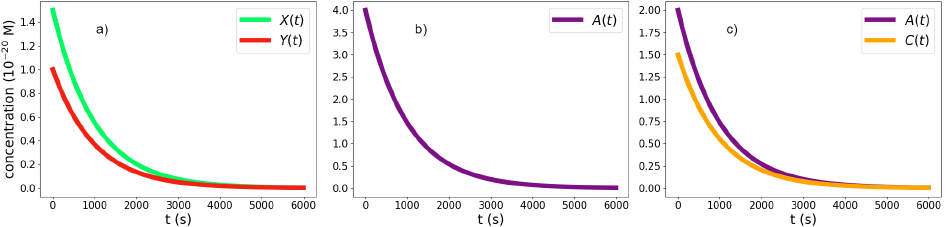
Figure 1. Time dependence of ( a ) X ( t ) and Y ( t ) for RM1 (left) calculated assuming the [ A ] (cid:29) [ Z ] case, ( b ) A ( t ) for the one-currency mechanism in RM1 (middle), and ( c ) A ( t ) , C ( t ) for RM2s (right), calculated considering the [ Z ] (cid:29) [ A ] case. The composite currency C ( t ) has the same time profile as that of the conventional currency A ( t )